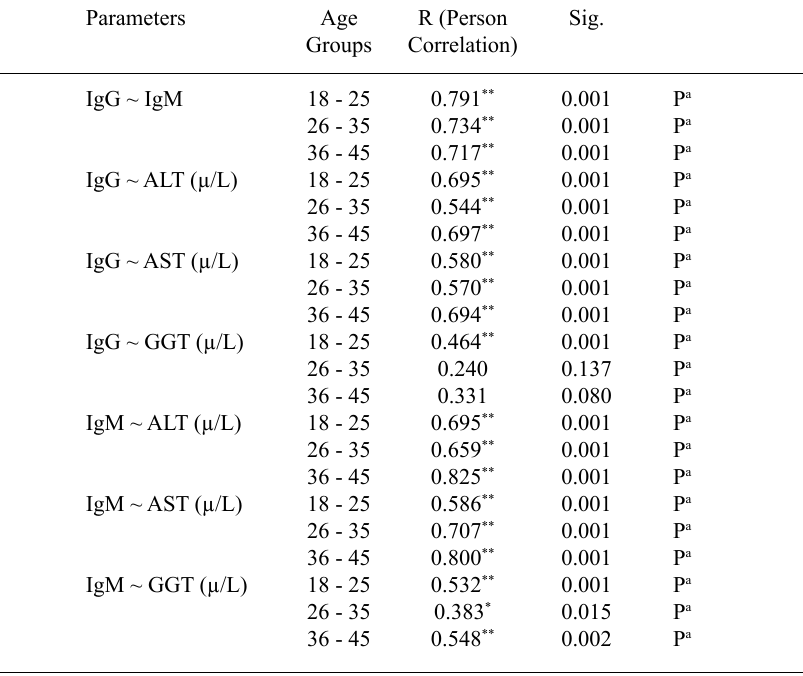
Table 2. Pearson’s correlations between the measured parameters